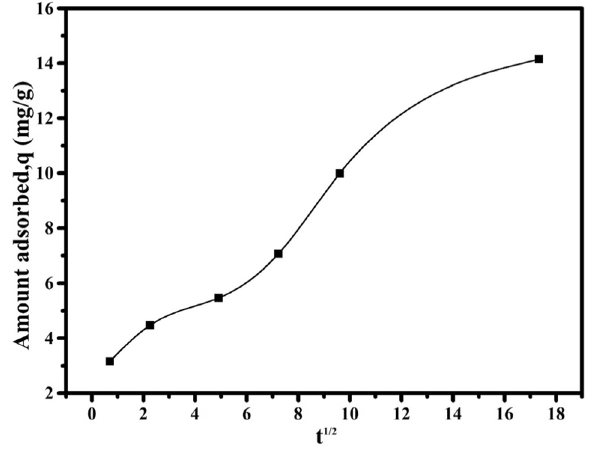
Fig. 14 Weber and Morris diffusion model for the separation of MB dye on PBF adsorbent